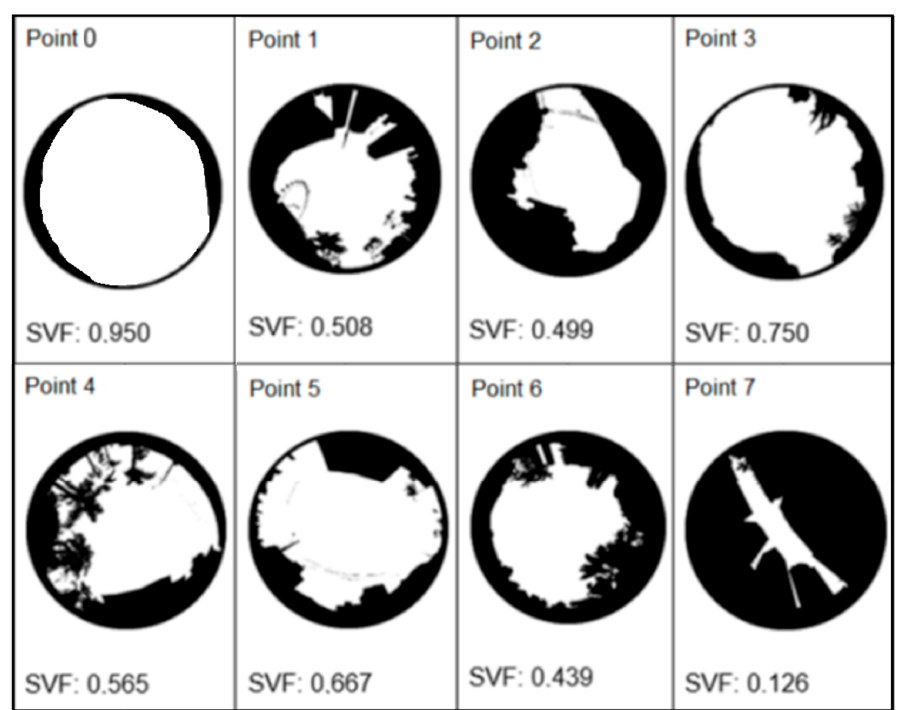
Figure 7. RayMan SVF values of collection points. Source: the authors (2022).